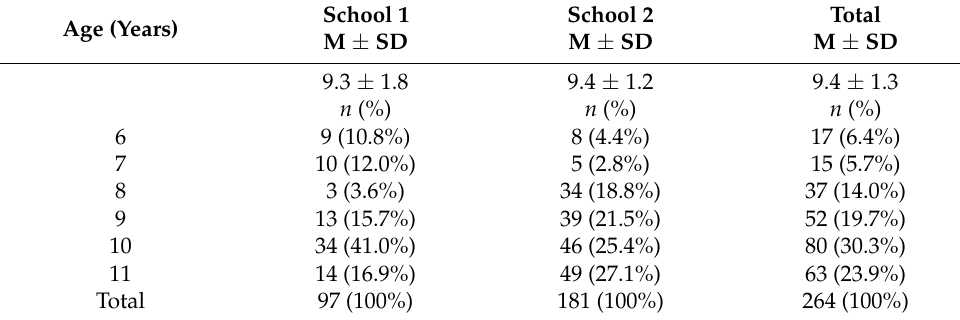
Table 1. Descriptive data of the